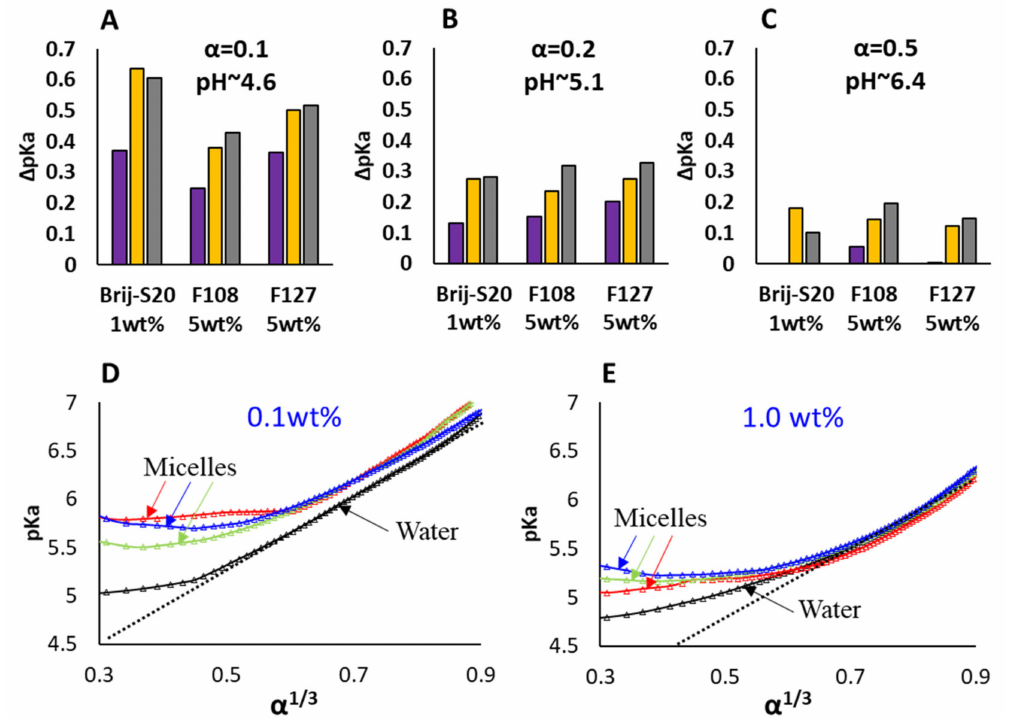
Figure 6. ( A – C ) Shift of pKa values (compared to DIW) of PAA 0.1 wt% with Brij-S20 \ F108 \ F127 (1 \ 5 \ 5 wt%). ( A – C ) are of 10%, 20% and 50% ionization, respectively. PAA 5kDa ( • magenta), 30 kDa ( • orange) and 100 kDa ( • grey). ( D , E ) are pKa as a function of α 1/3 plots of PAA 30kDa ( D )